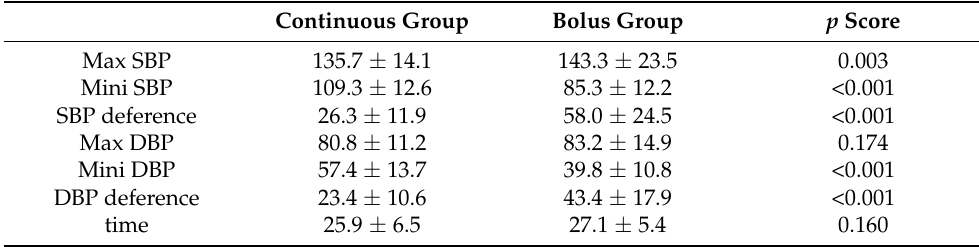
Table 2. The details of blood pressure-related parameters and the time from spinal anesthesia to delivery.